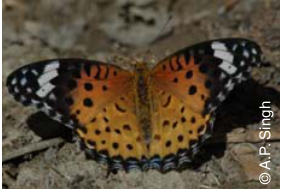
Image 67. Indian Fritillary, Argyreus hyperbius female (upper)